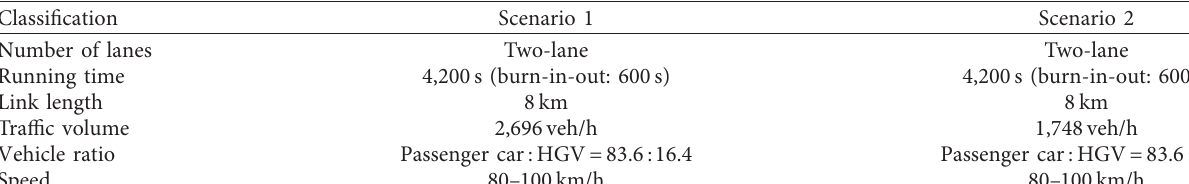
Figure 7: Spatial range of the section on a real road selected for data collection (empirical evaluation). Table 6: Scenario descriptions of empirical evaluation.